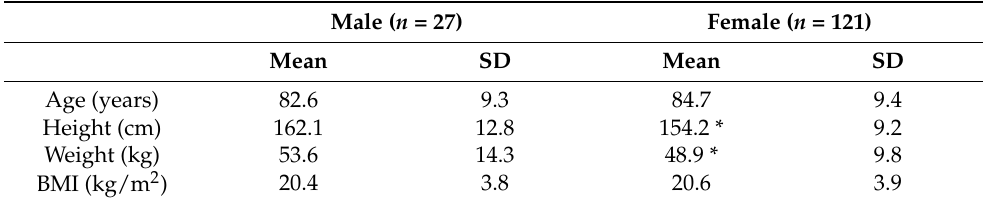
Table 2. Characteristics of the study population according to sex.